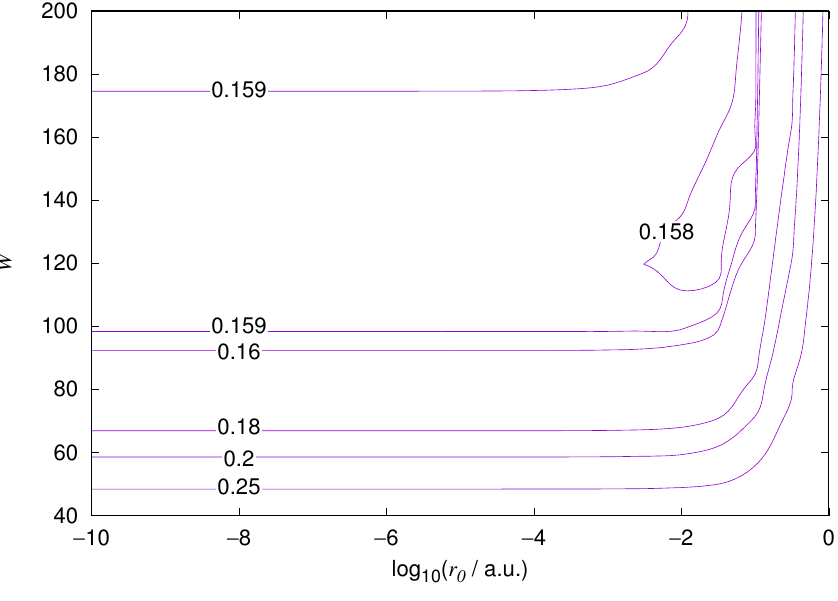
Figure 7. The ground state energy of helium atom. The HF limit is given in Table 1. Notations as in Figure 1.